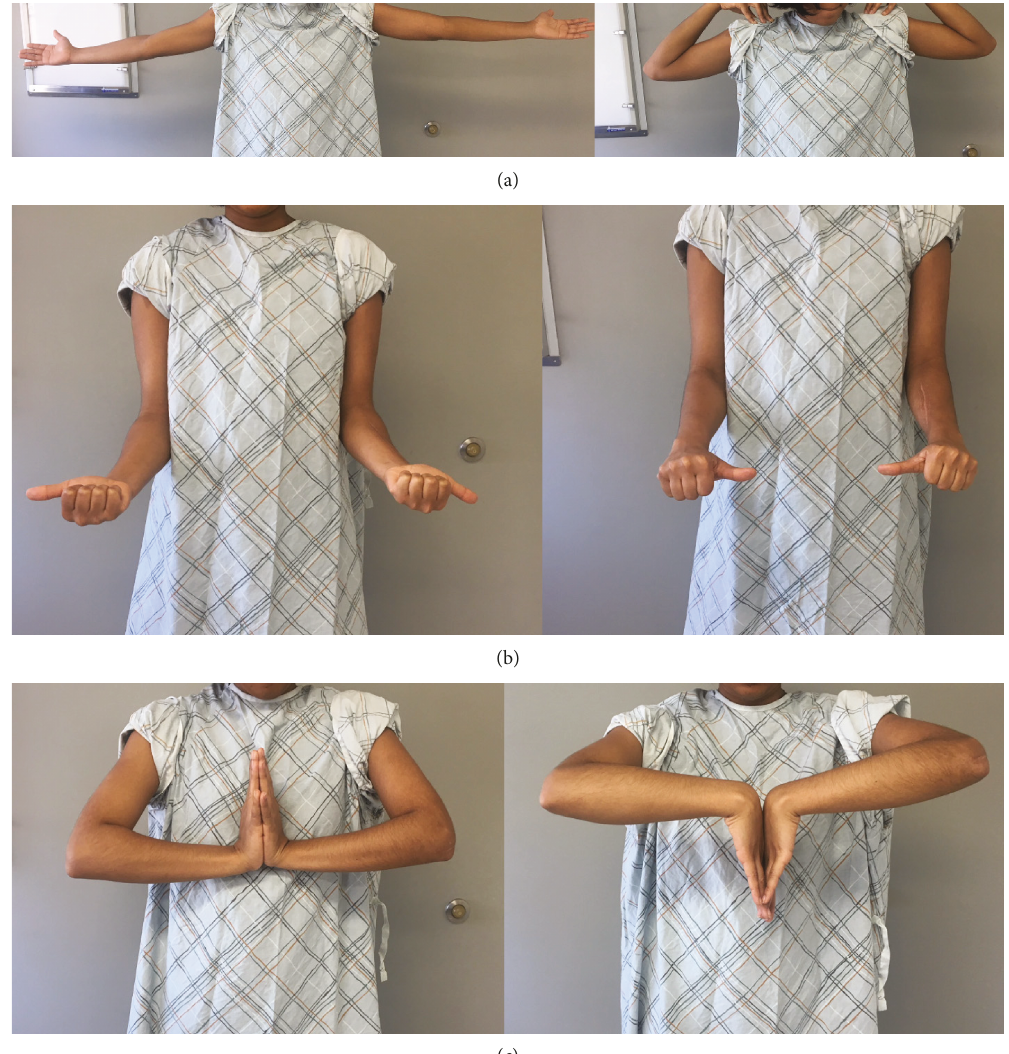
Figure 4: Clinical photographs of the patient at 1 year postoperatively demonstrating elbow fl exion and extension (a), forearm pronation and supination (b), and wrist fl exion and extension